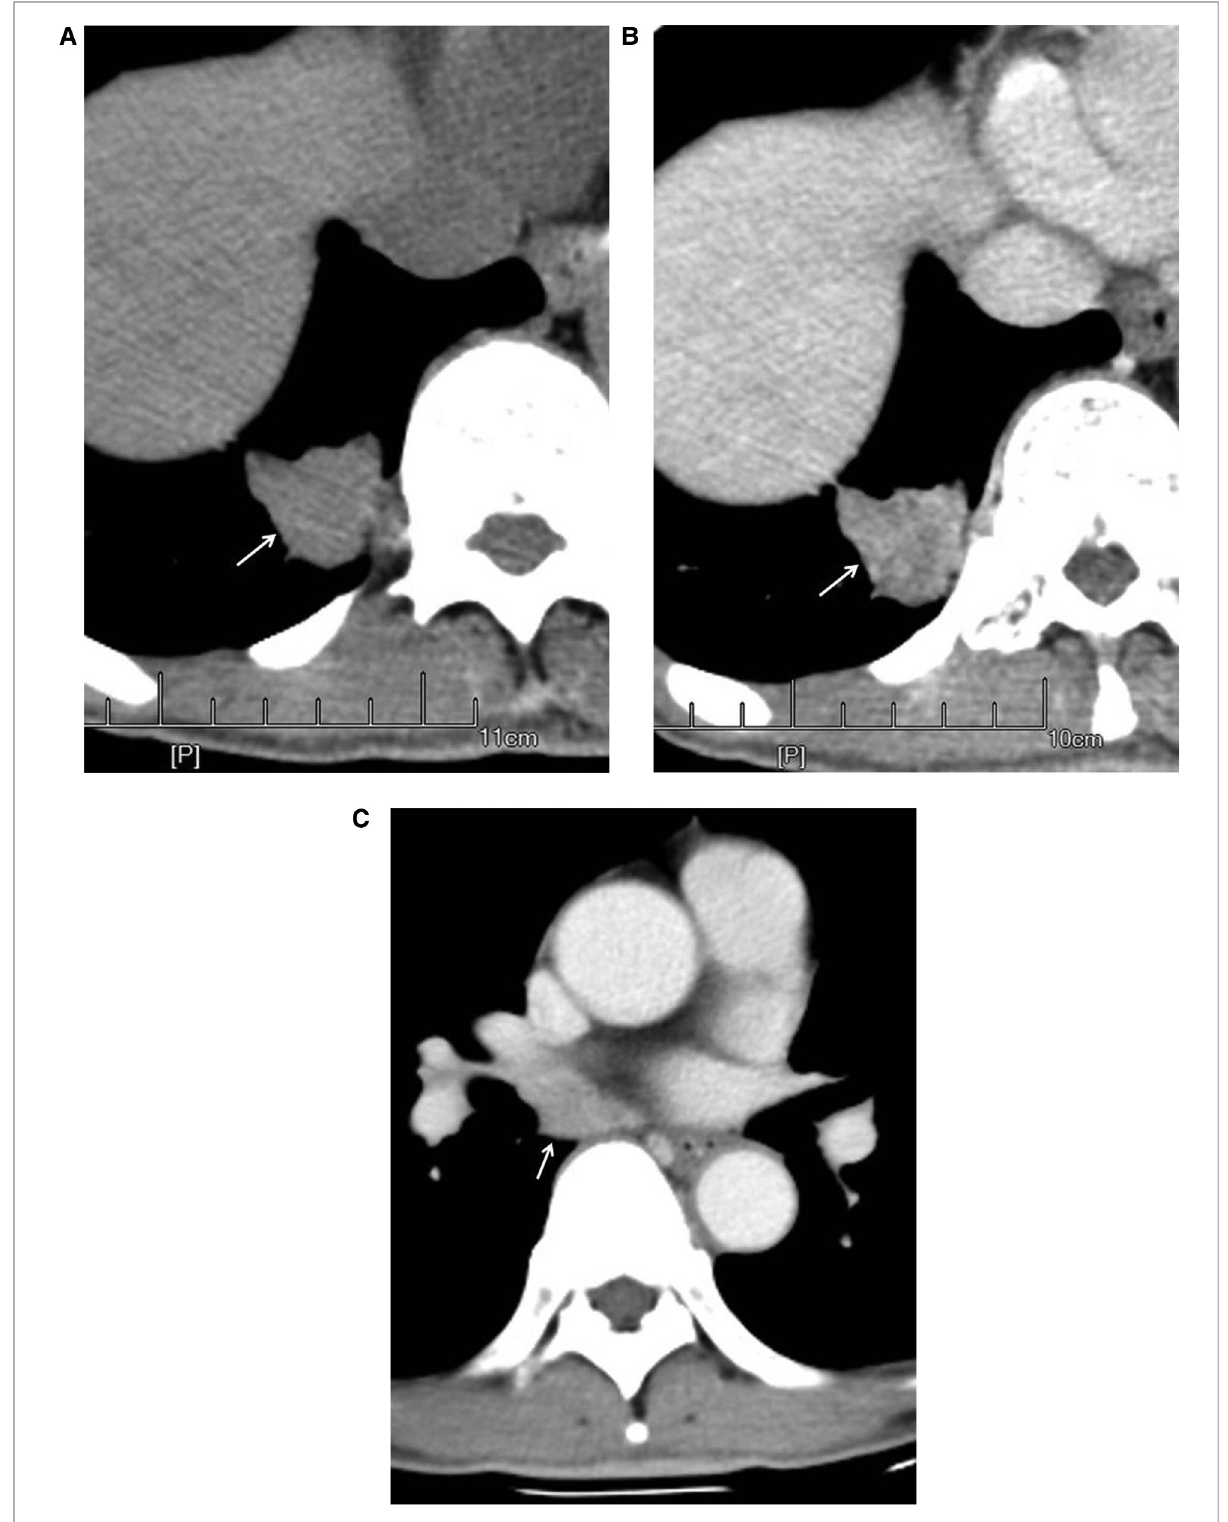
FIGURE 4 Male, 67 years old, with adenosquamous carcinoma in the medial basal segment of the lower right lung (moderately differentiated degree) with hilar and mediastinal lymph node metastases. CT showed a solid nodule. The left fi gure ( A ) shows unenhanced imaging and a solid nodule (arrow). The right fi gure ( B ) shows enhanced imaging and a heterogeneously enhanced nodule (arrow). Figure ( C ) shows lymphadenectasis in the right lung hilum and subtuberances (arrow) that were lymphatic metastases proven by